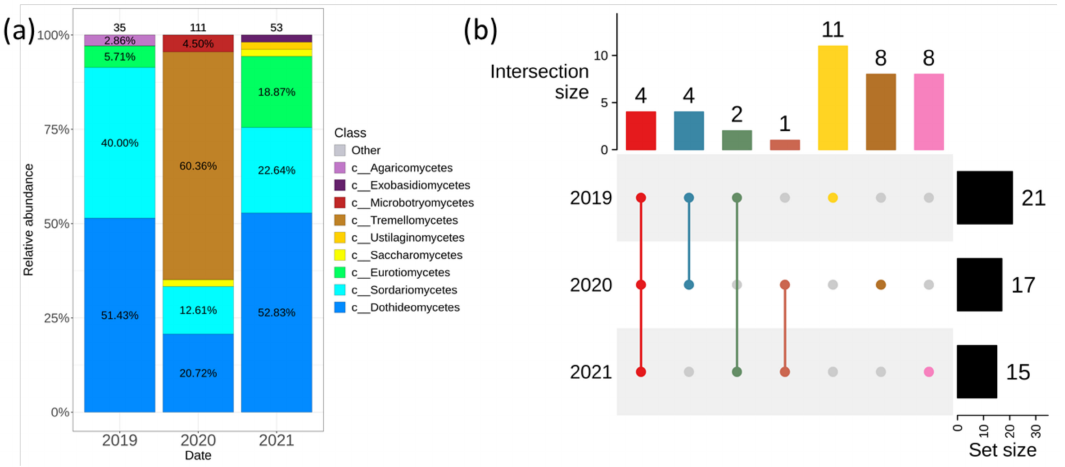
Figure 4. Composition of endophytic fungal community in wild grape Vitis amurensis depending on the year of material collection according to the cultivation-dependent (fungal sowing (Sow)) approach. ( a ) Class level taxonomical bar plots for the fungal community composition in 2019–2021; ( b ) Genus level UpSet diagrams depicting overlapping taxa of sow Taxa were filtered based on relative abundance of >0.1% for each biocompartment. Number of colonies are shown above taxonomical bar